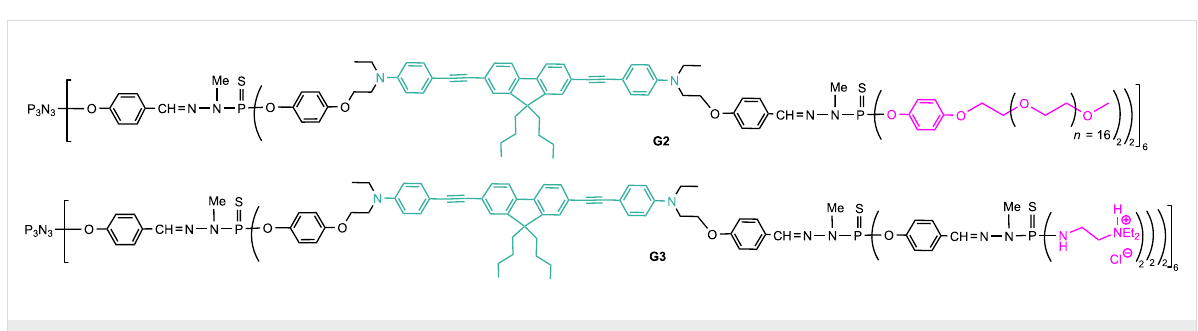
Figure 6: Other types of dendrimers having TPA fluorophores as branches and water-solubilizing functions on the surface.